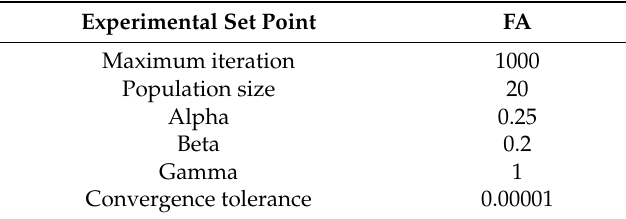
Table 3. The experimental set points of